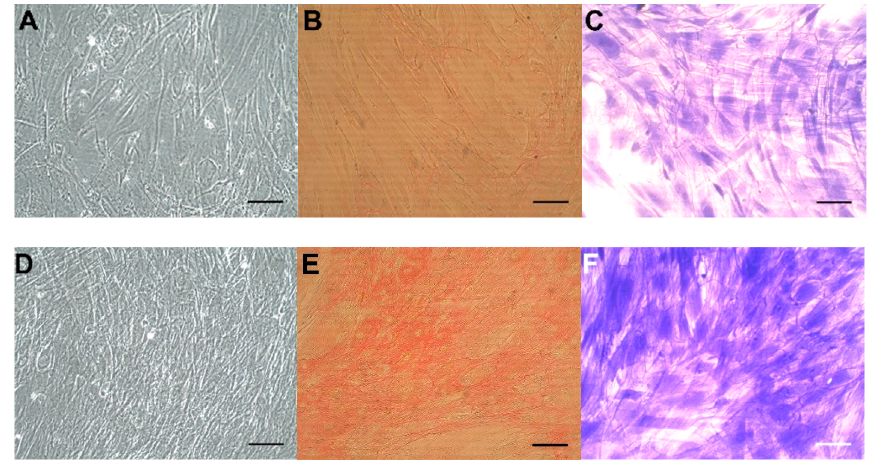
Figure 5. CoReFs treated without ( A – C ) or with 1 ng/mL TGF- β 1 for 8 days ( D – F ), fixed and stained with Sirius red ( B , E ) or crystal violet ( C , F ). OD 540nm for ( B ) was 0.22, and for ( E ) was 0.59. OD 590nm for ( C ) was 0.54 and for ( F ) was 1.46. Scale bars, 100 µm. Cells in ( A ) and ( D ) were trypsinized (2 mL 0.05% trypsin-0.02% EDTA/well for 10 min at 37 °C) and counted by a Countess™ automated cell counter (Thermo Fisher Scientific, Waltham, MA, USA). The number of cells in ( A ) was 0.77 × 10 6 and in ( D ) was 1.2 × 10 6 .